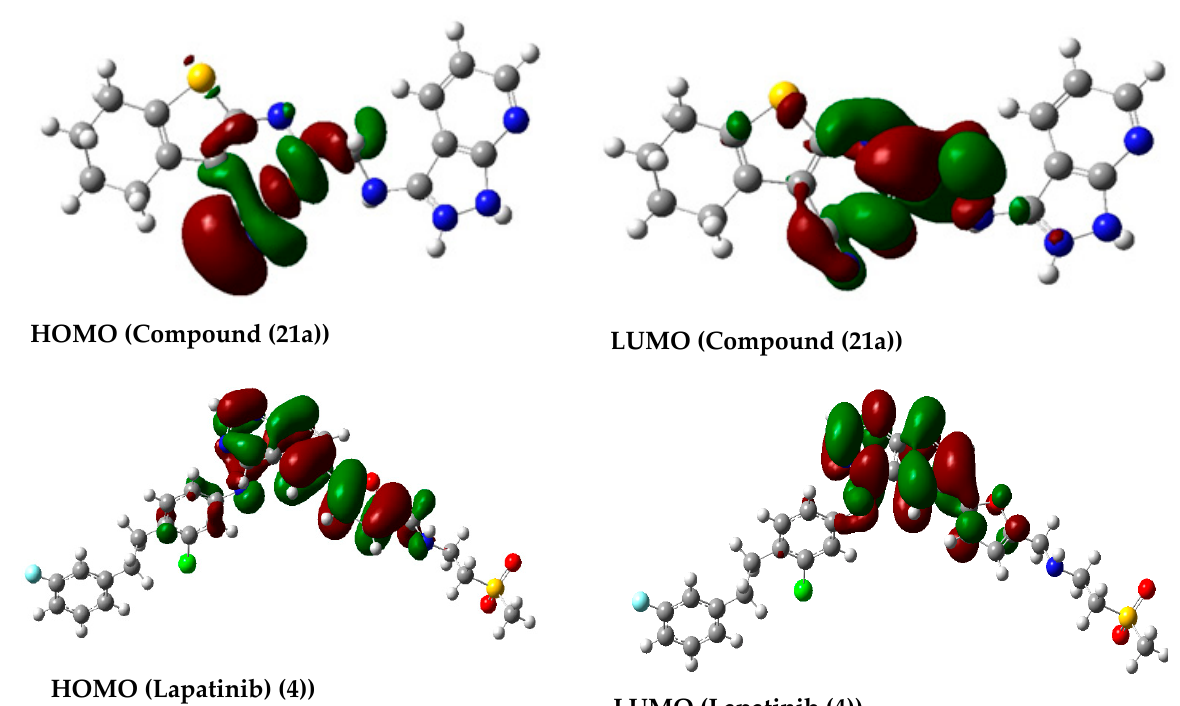
Figure 9. Highest occupied molecular orbital (HOMO) and lowest unoccupied molecular orbital (LUMO) maps for compound ( 21a ) and lapatinib ( 4 ) from DFT calculations. Green indicates positive molecular orbital and red indicates negative molecular orbital.